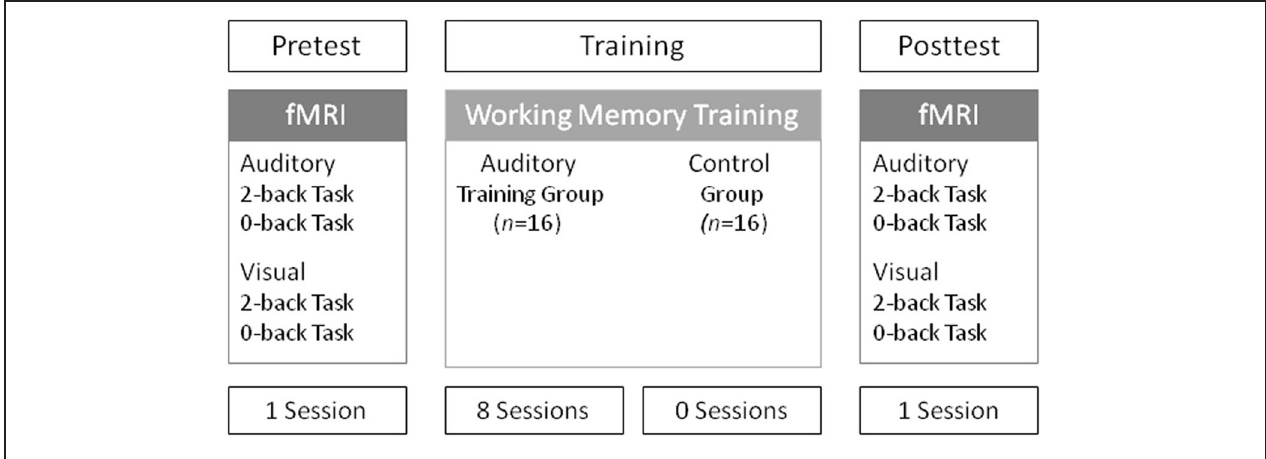
FIGURE 1 | Schematic description of the experimental design. Both groups performed the same auditory and visual 2-back and 0-back control task in the pretest and posttest fMRI session. During the training interval,